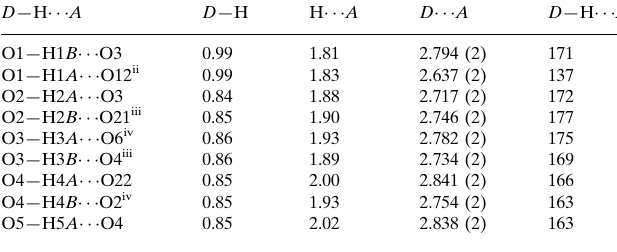
Hydrogen-bond geometry (A˚ , (cid:3)